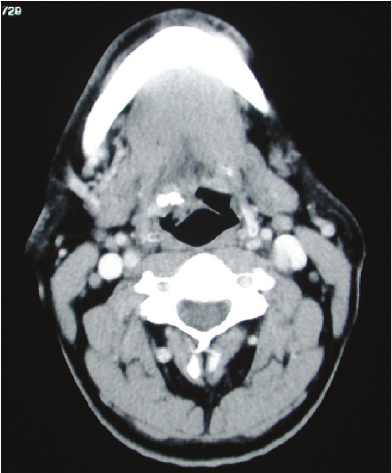
Figure 1: CT scan of the lesion. The lesion can be seen on the right side of tongue base.